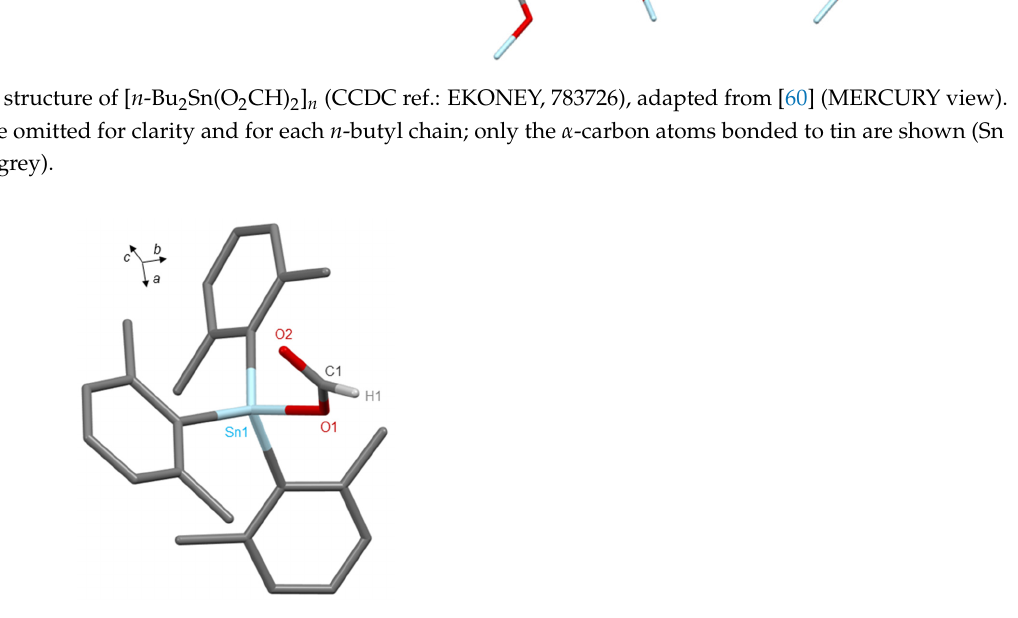
Figure 9. Molecular structure of Dmp 3 SnOC(O)H (dmp = 2,6-dimethylphenyl) (CCDC ref.: EKONIC, 783727), adapted from [60] (MERCURY view). Hydrogen atoms are omitted for clarity except that of the formate group (Sn light blue, O red, C grey, H white).